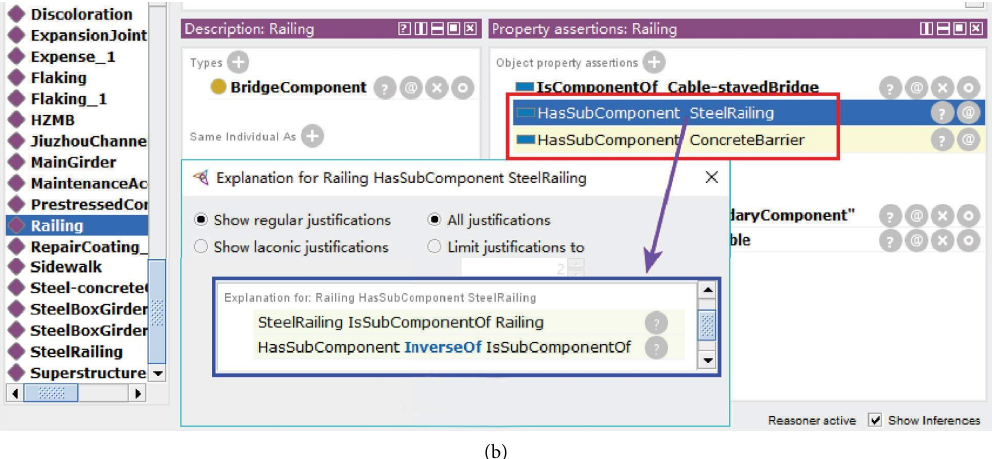
Figure 9: Prot´eg´e screenshot of the inference process of ontology reasoning: (a) before the reasoning and (b) after the reasoning.